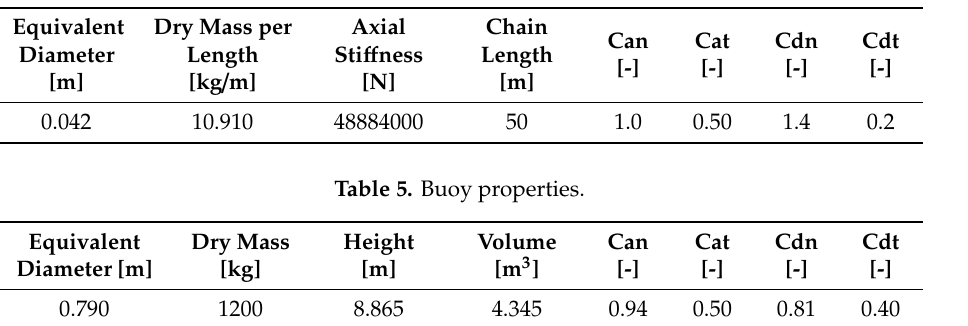
Table 4. Line properties.